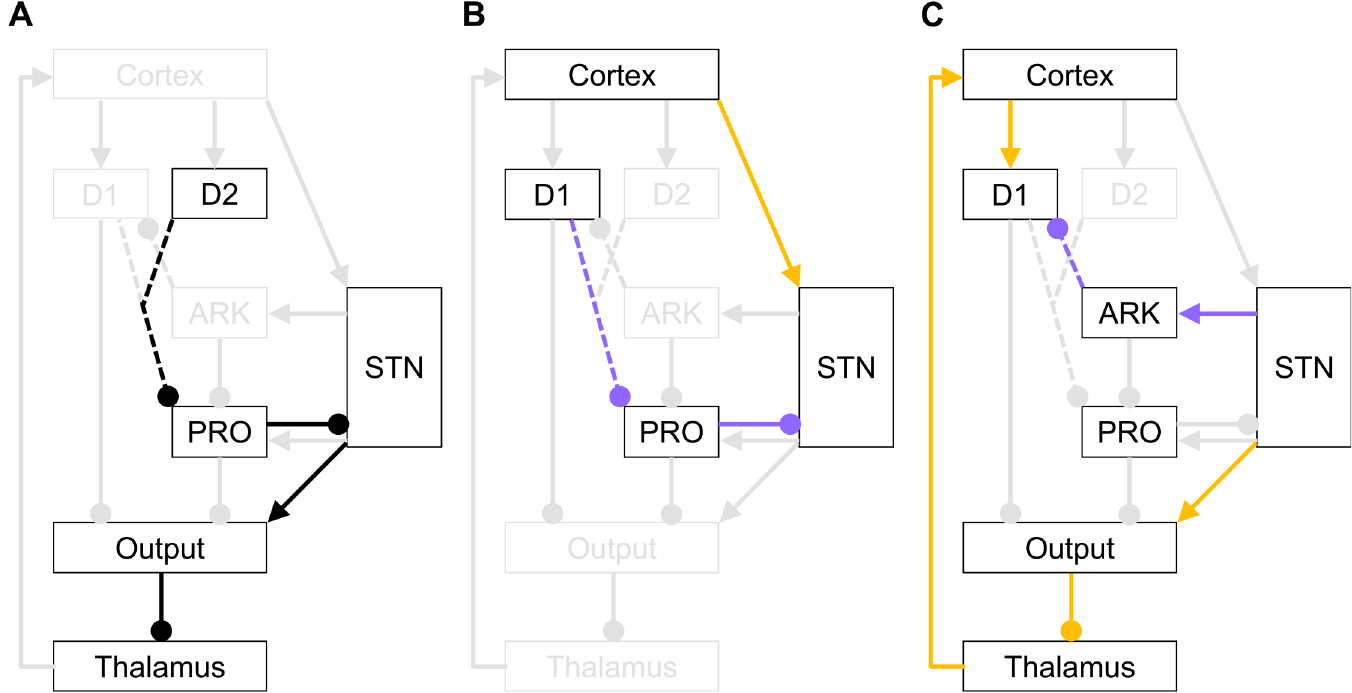
Fig 8. Connectivity between GPe and striatum. Rectangles denote neural populations: D1 and D2 label striatal neurons with D1 and D2 receptors, while PRO and ARK label prototypic and arkypallidal neurons respectively. Arrows and lines ending with circles denote excitatory and inhibitory connections respectively. Black and coloured parts of the circuit highlight the pathways illustrated in each panel. Purple pathways denote routes alternative to those shown in orange. The connections between striatum and GPe are dashed to indicate that it is not known which groups of neurons in striatum and GPe are interconnected – the figure shows only the hypothetical connections discussed in the main text. (A) Part of the indirect pathway connected with movement inhibition. (B) Routes providing evidence for actions to STN. (C) Routes providing normalization to the